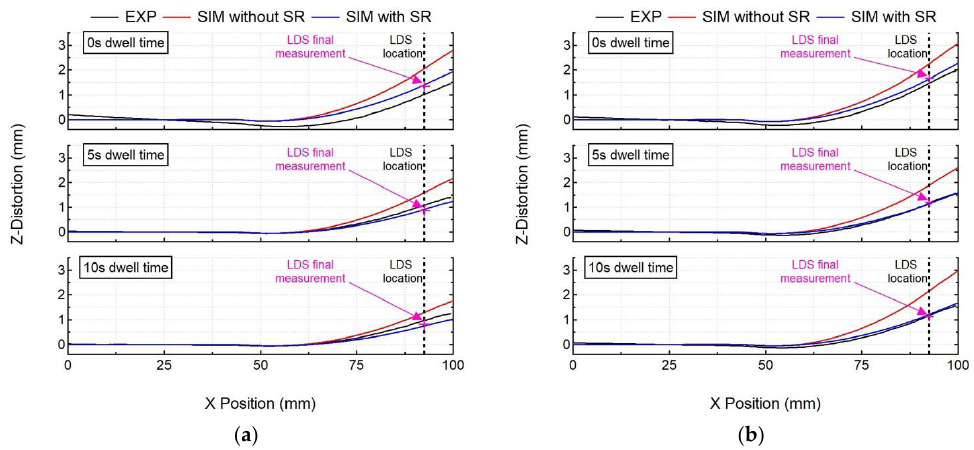
Figure 9. Comparison of numerical results (SIM with and without stress relaxation (SR)) with experimental post-process line distortion results of the optical scanner (EXP) for all cases ( a ) single- bead wall, ( b ) double-bead wall.